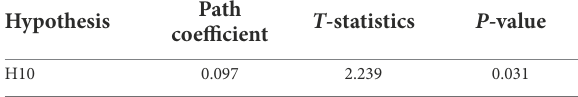
TABLE 14 The result of moderation analysis.